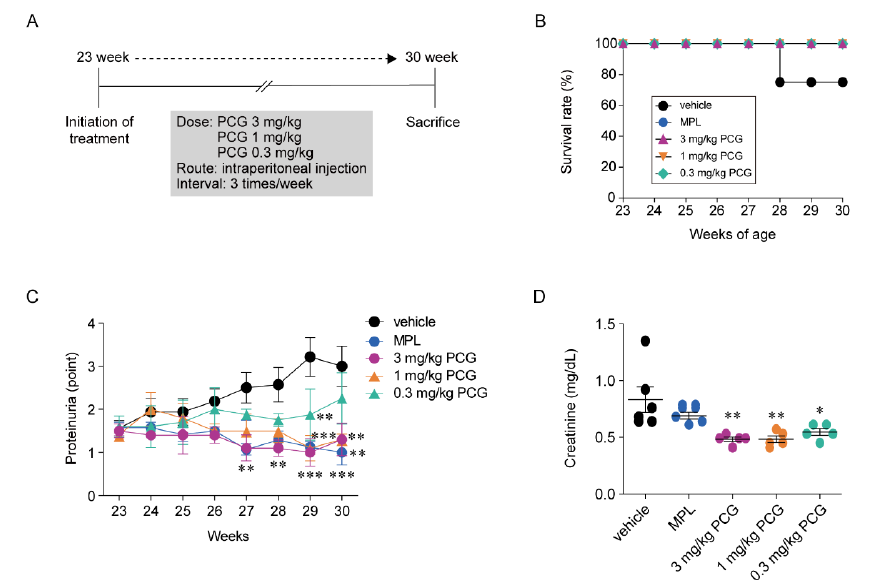
Figure 2. PCG preserves renal function in lupus-prone mice. ( A ) Treatment schedule for lupus-prone mice with phosphate-bu ff ered saline (vehicle), methylprednisolone (MPL) (7 mg / kg / day), and 0.3 mg / kg, 1 mg / kg, and 3 mg / kg PCG is presented. PCG was applied 3 times a week. ( B ) The survival rate of lupus-prone mice treated with vehicle, MPL, and three doses of PCG (mean ± SEM, n = 5–8 / group). ( C ) The amount of proteinuria in lupus-prone mice was measured twice a week using albumin reagent strips (mean ± SEM, n = 5–8 / group). ( D ) Serum creatinine concentration was measured through a kinetic colorimetric method (mean ± SEM, n = 5–7 / group). * p < 0.05, ** p < 0.01 and *** p < 0.001 versus vehicle. Two-tailed Student’s t -test ( C and D ).